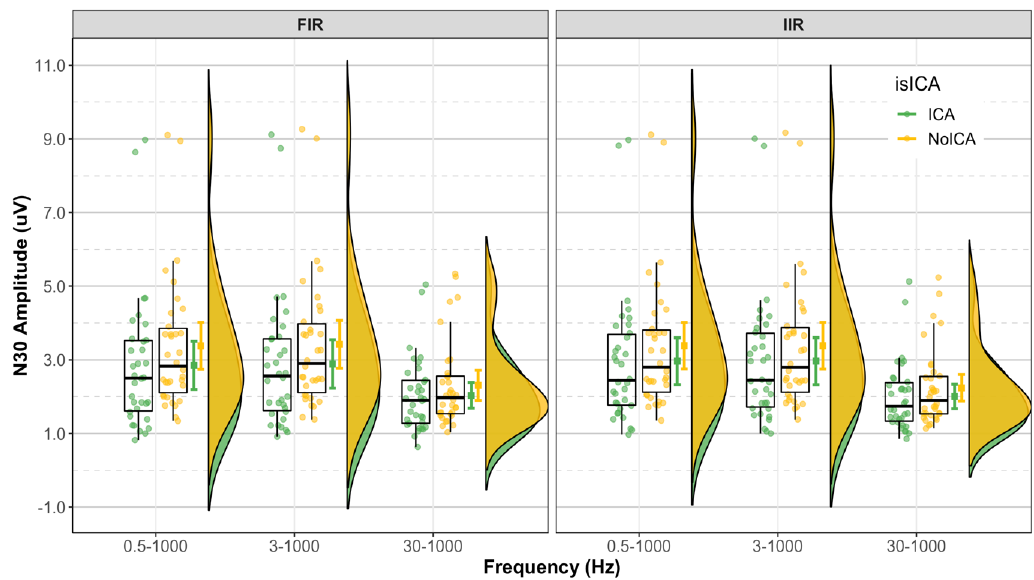
Figure 2. N30 amplitude. Dots represent N30 amplitude of each dataset. Boxplots show the median, 25th and 75th percentiles. The error bars represent mean ± 95% CI. The distribution plots show the density distribution estimated by a Gaussian kernel with SD of 1.5. The figure was made using the code provided by [29]. Table 2. Estimated coe ffi cients from the statistical model. Significant e ff ects ( p < 0.05) are in bold text. Model Coe ffi cients